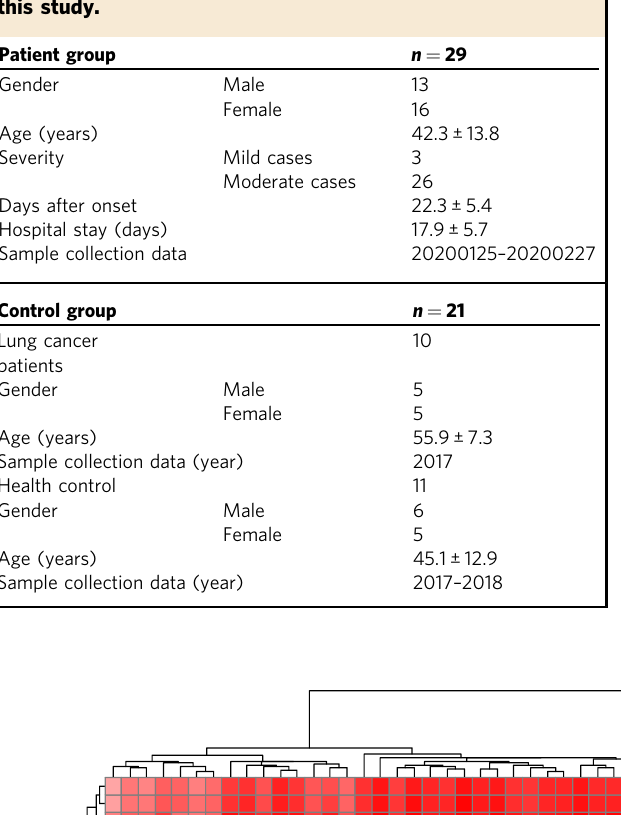
Table 1 Detailed information on serum samples tested in this